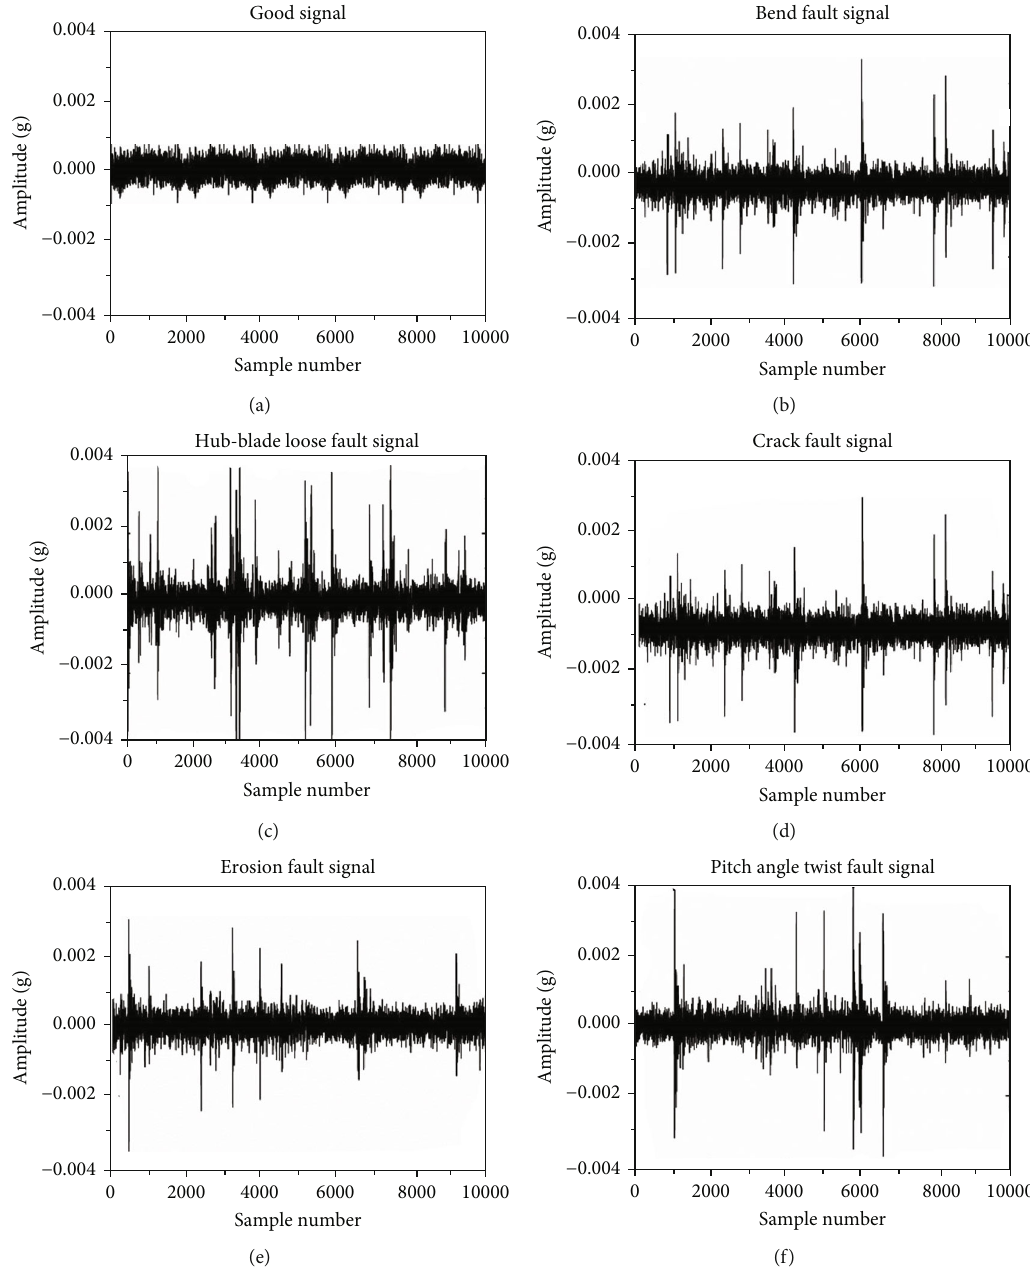
Figure 4: (a) Good condition signal plot. (b) Signal plot for bend condition. (c) Signal plot for crack condition. (d) Signal plot for erosion condition. (e) Signal plot for hub-blade loose condition. (f) Signal plot for pitch angle twist